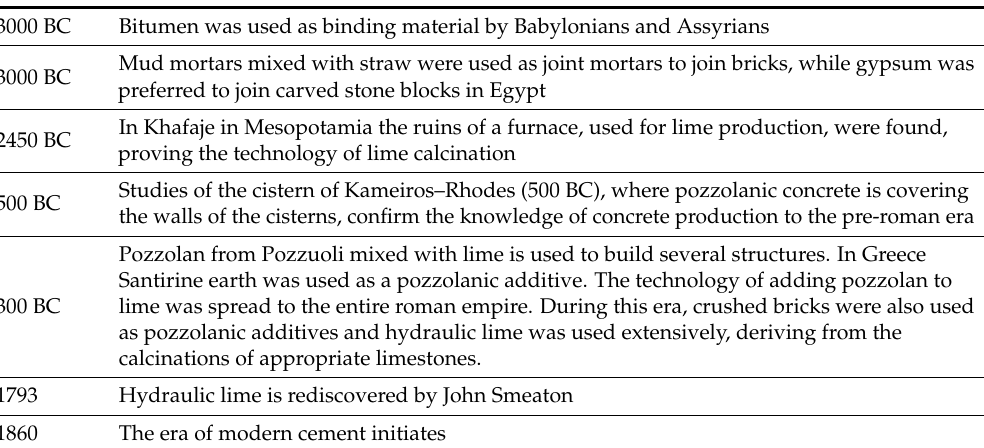
Table 5. Summarized timeline of mortar